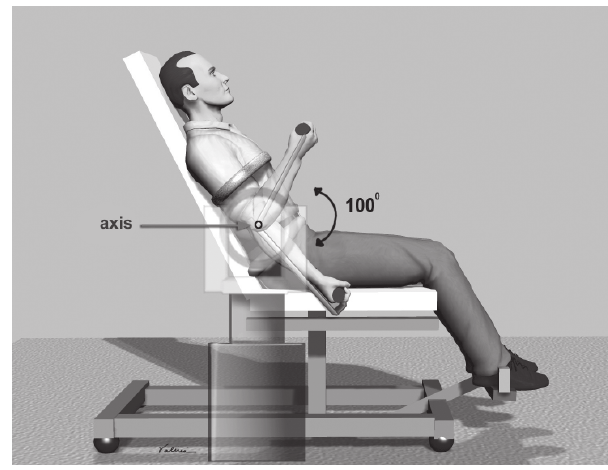
Figure 1 - Position of the